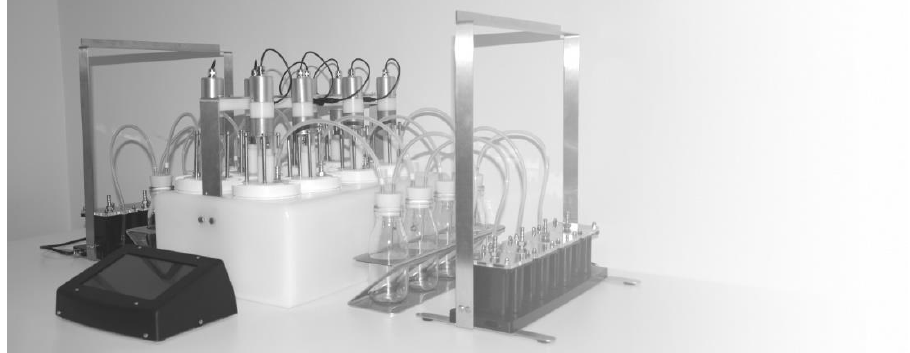
Figure 2. CJC biomethane potential system (courtesy CJC labs).